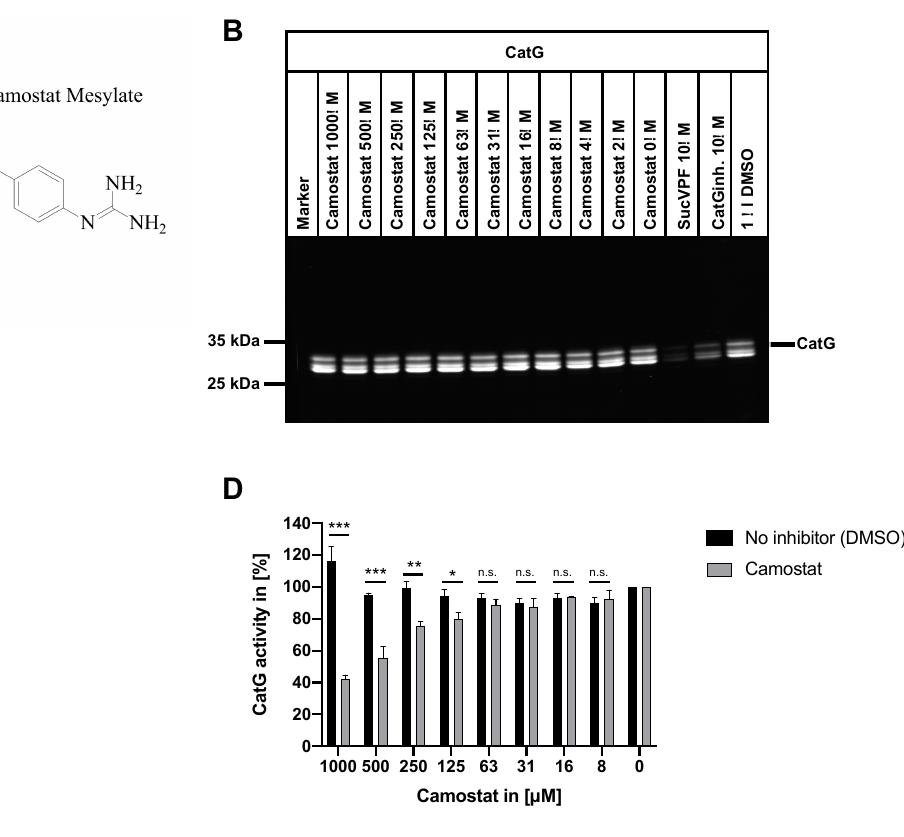
Figure 1. Analysis of the inhibition capacity of camostat towards CatG. ( A ) The chemical structure of the trypsin-like serine protease inhibitor camostat. ( B ) Activity-based protein profiling of CatG by using MARS116-FAM with different concentrations of camostat, Suc-Val-Pro-Phe P (OPh) 2 (SucVPF), or the CatG inhibitor (CatGinh) was performed. DMSO was used as a solvent control. One out of three ( n = 3) independent experiments is shown. ( C ) CatG activity was analyzed by using the colorimetric substrate 4-(((S)-3-methyl-1-((S)-2-(((S)-1-((4-nitrophenyl)amino)-1-oxo-3-phenyl-propan-2-yl)-carbamoyl)pyrrolidin-1-yl)-1-oxobutan-2-yl)-amino)-4-oxobutanoic acid (Suc-VPF-pNA). In order to validate the assay, CatG, CatG with SucVPF, CatG with camostat, or the vehicle control CatG with DMSO (the volume of DMSO for camostat was higher) were incubated prior to adding Suc-VPF-pNA. The substrate turnover of Suc-VPF-pNA was analyzed at 405 nm. ( D ) CatG was preincubated with different concentrations of camostat or DMSO for 15 min at RT. Afterwards, the colorimetric substrate was added to the assay to lead the enzymatic digest. Three independent experiments are summarized, n = 3. p < 0.05 (*), p < 0.01 (**), p < 0.001 (***), p < 0.0001 (****), or n.s. = not significant.